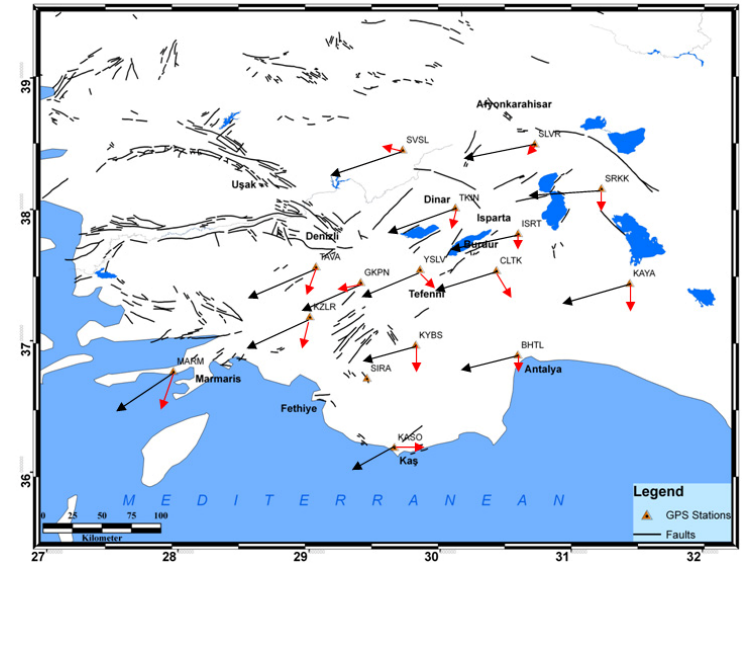
Figure 5. Residual values between measured horizontal values (red arrow) and Euler pole values of McClusky (black